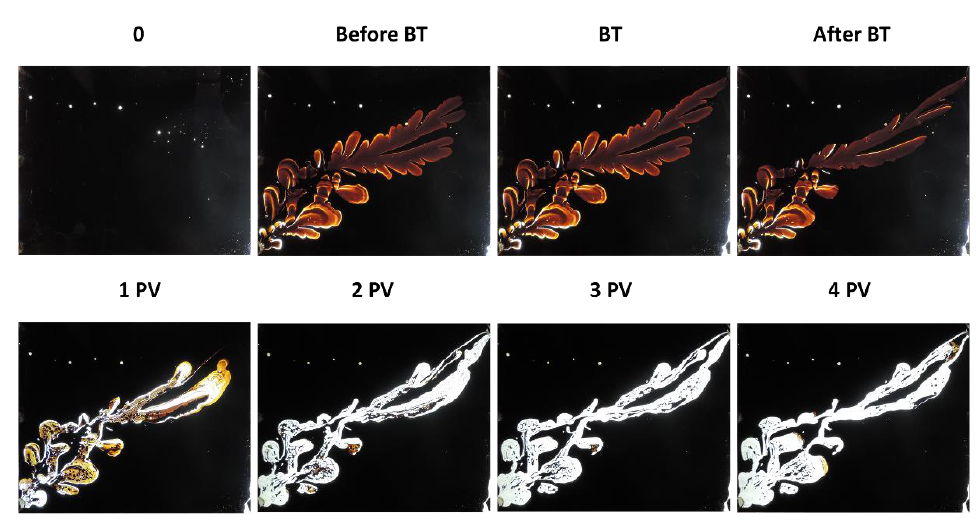
Figure 8. Crude oil displacement by surfactant flooding at 0.3 mL/min.